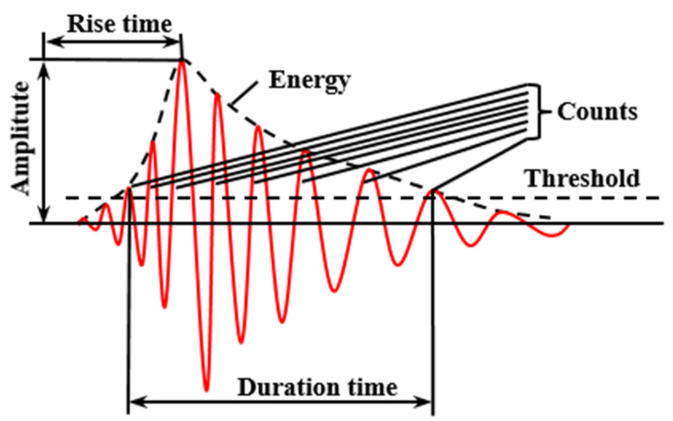
Figure 4. Basic parameters of an AE